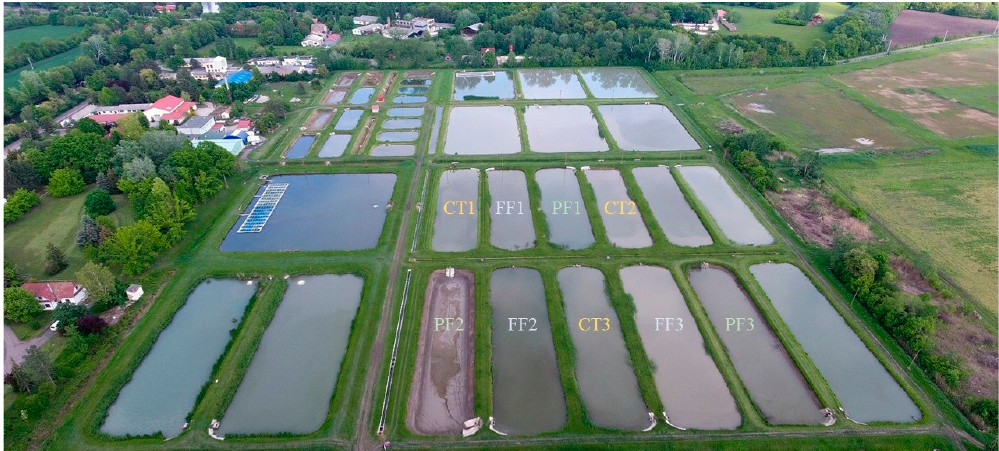
Table 1. The ingredients of the experimental and conventional, commercial feeds.